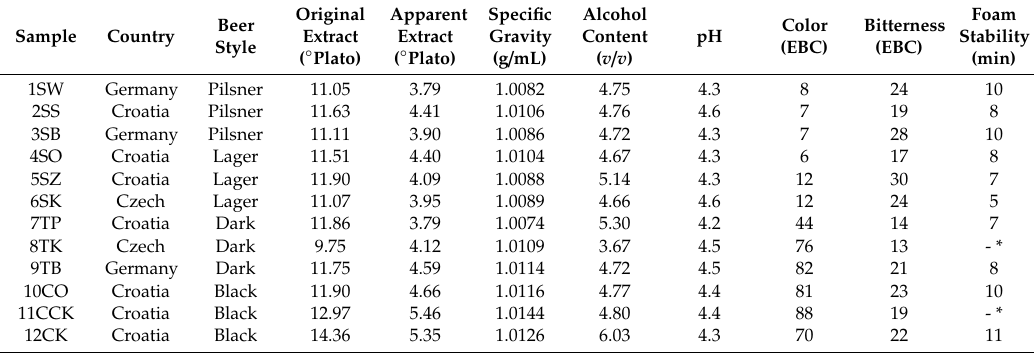
* no foam detected; values are means of three measurements ± SD.